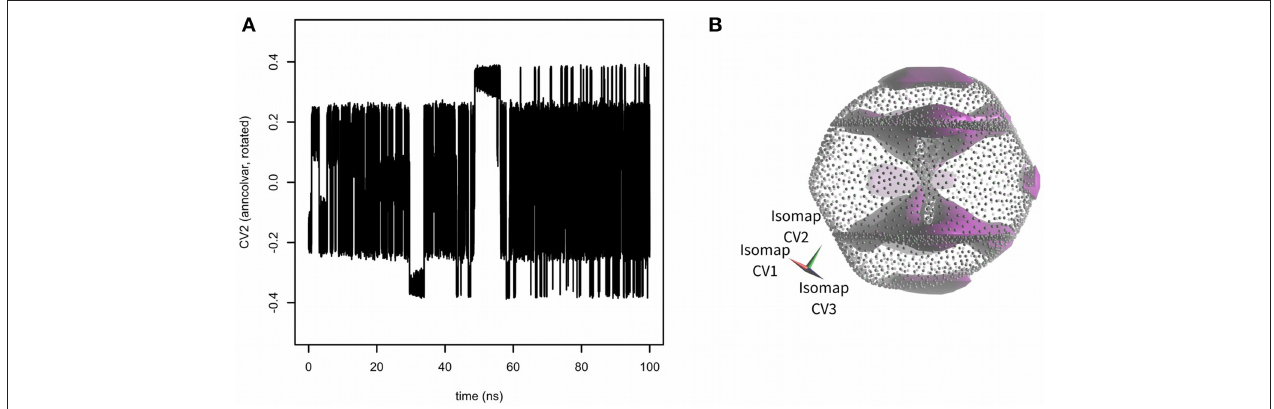
FIGURE 3 | Sampling of CVs in 100 ns metadynamics with Isomap low-dimensional embeddings calculated by anncolvar (A) . Free energy surface depicted as an isosurface (in violet) at + 30 kJ · mol − 1 (relative to the global free energy minimum) (B) . Isomap embeddings were rotated by angle [0.00rad, 2.40rad, − 0.55rad] for better clarity.